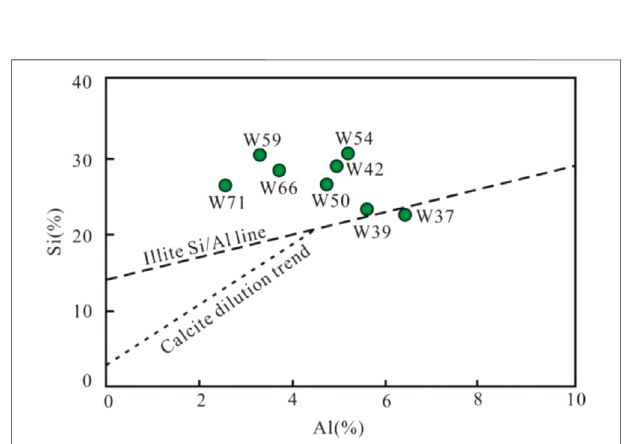
FIGURE 8 | Correlation between Al and Si